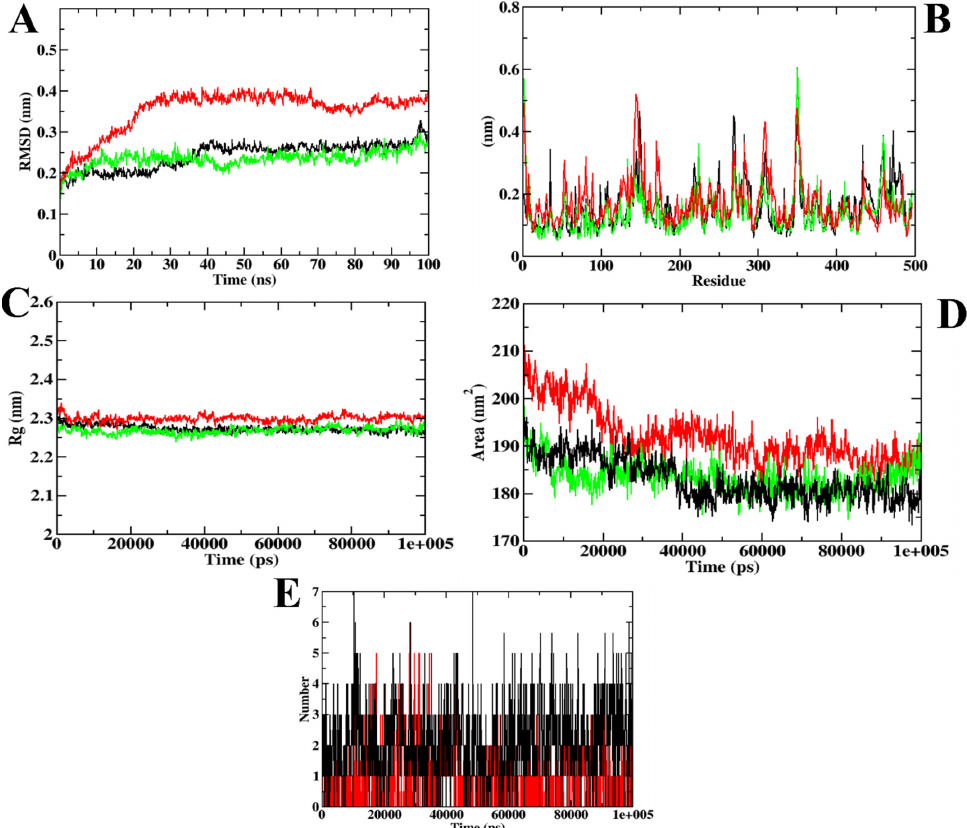
Figure 10. Visualization of MD trajectories obtained for ZINC02789441 and acarbose complexed with α -amylase; ( A ) RMSD, ( B ) RMSF, ( C ) Rg, ( D ) SASA, and ( E ) SASA. Green: apoprotein, red: protein–acarbose complex, and black: protein–ZINC02789441 complex. red: protein–acarbose complex, and black: protein–ZINC02789441